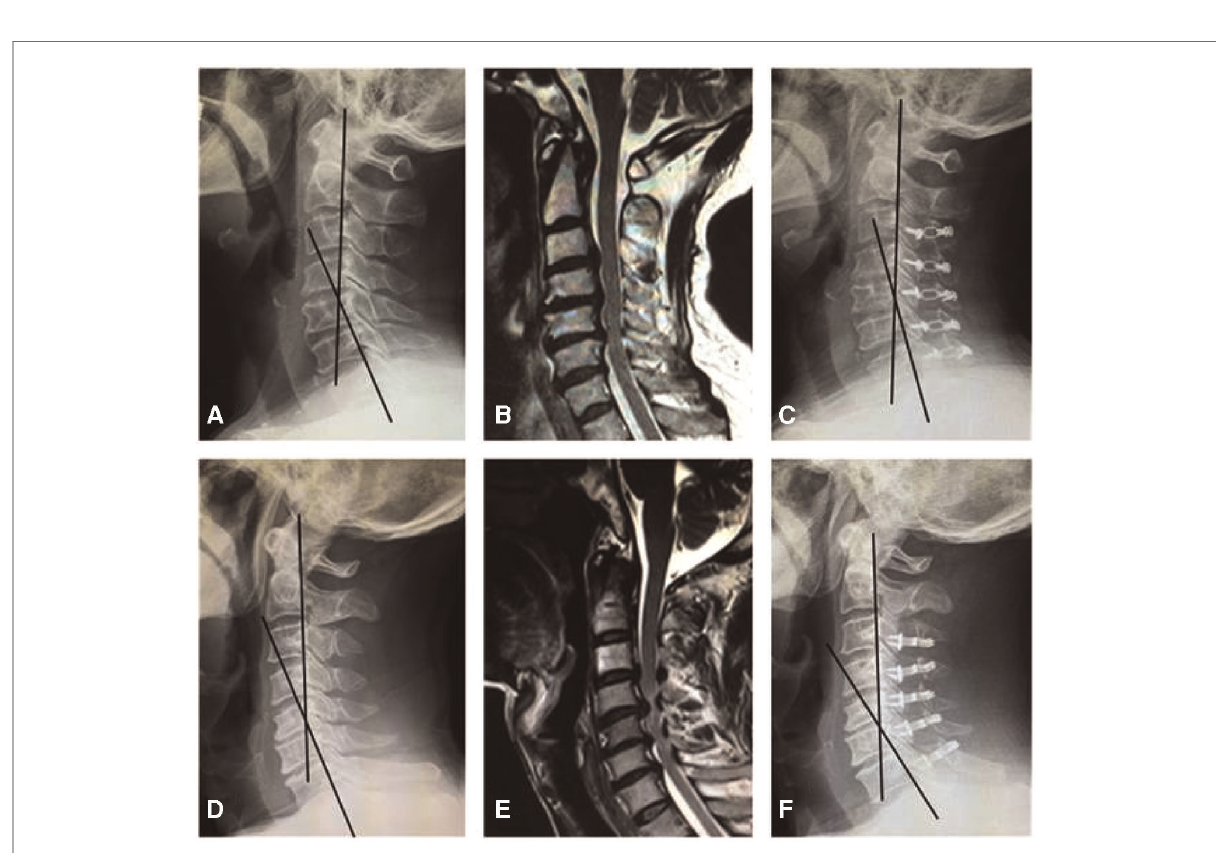
( D ) Preoperative lateral X-ray showed the CGA was 22.3°. ( E ) MR revealed spinal cord had both anterior and posterior compression. ( F ) Postoperative lateral X-ray showed the CGA was